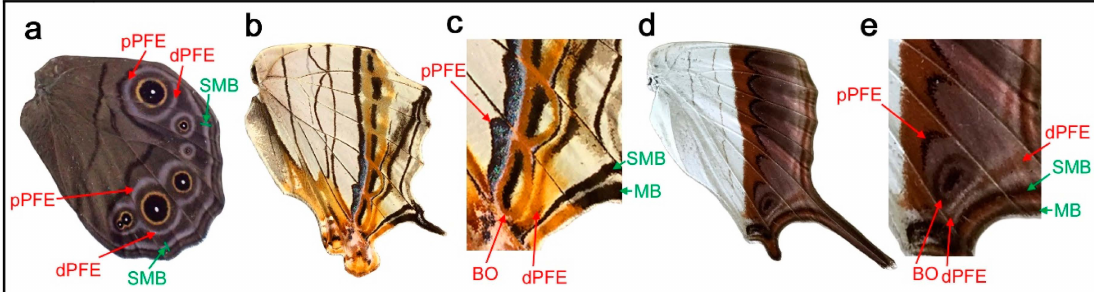
Figure 9. Exceptional cases of the distal elaboration rule. ( a ) Lethe diana . ( b ) Cyrestis thyodamas . ( c ) The distal area of the wing shown in ( b ). ( d ) Marpesia coresia . ( e ) The distal area of the wing shown in